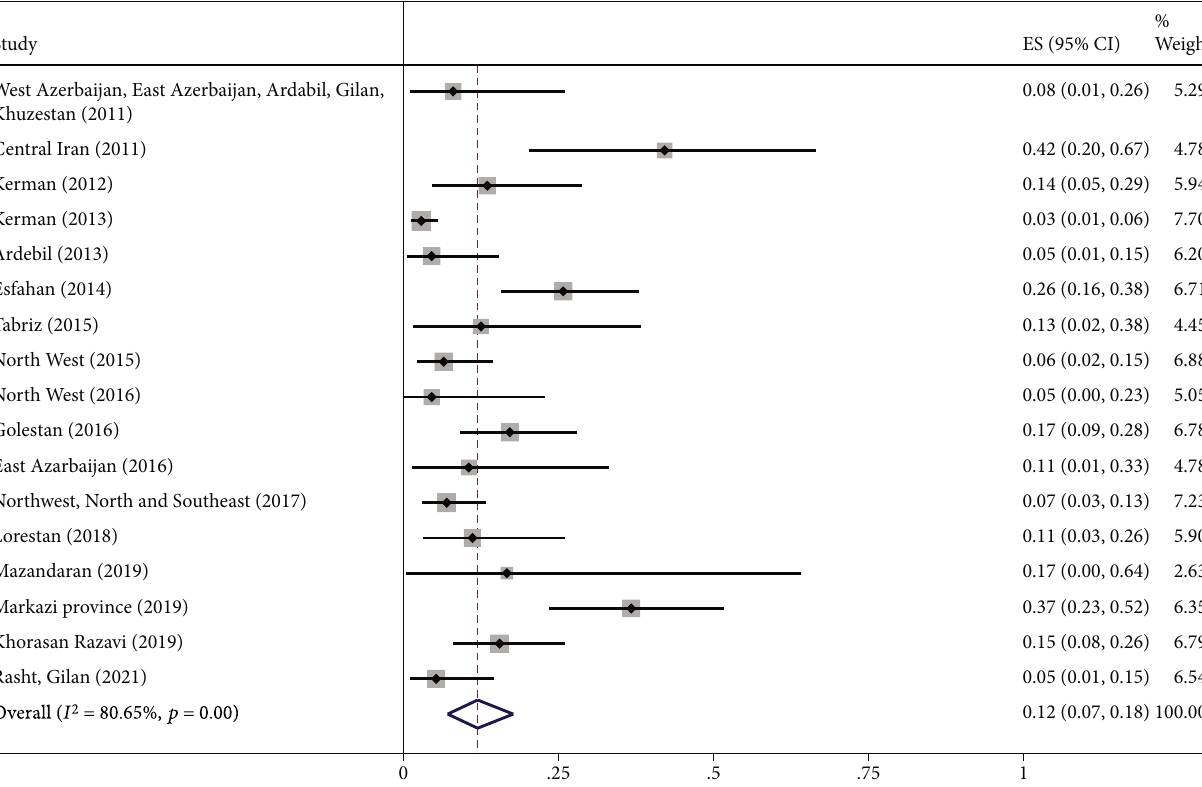
genotype prevalence in 3